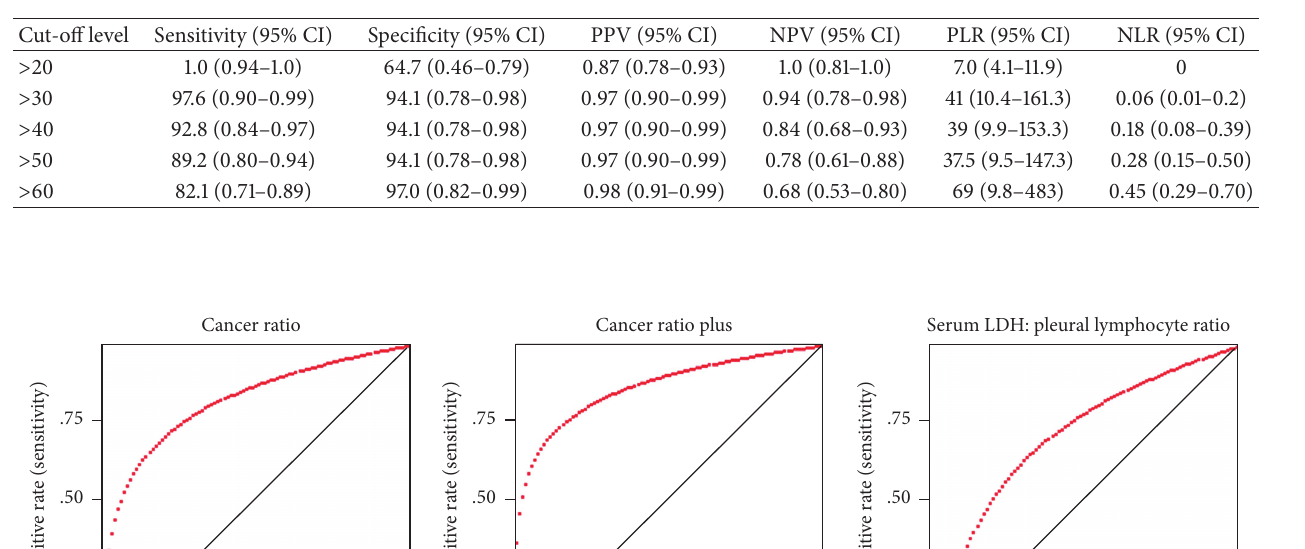
Table 4: Cut-off for cancer ratio plus (cancer ratio: pleural fluid lymphocyte count).